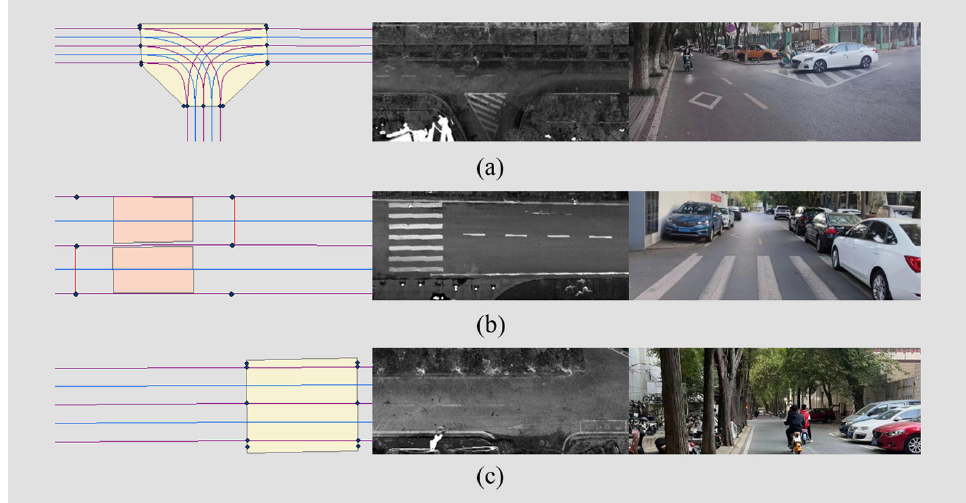
Figure 3. The HD-Map information of three campus scenes ( a – c ). the vector layer, the purple lines represent the lanes, the blue lines represent the midlines of the lanes and the blue dots are the topology points where the roads connect. The yellow areas are the junctions, the pink area is the sidewalk and the red lines are the stop lines.